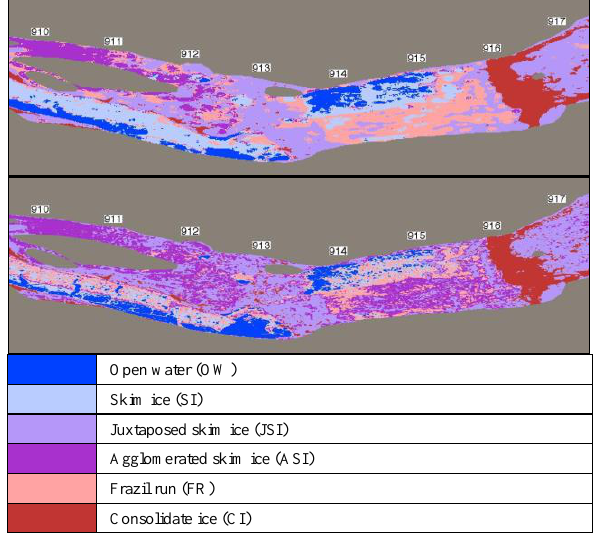
Figure 6. River ice types on 08.12.2013 based on RADARSAT- 2 (upper image) and TerraSAR-X (lower image)